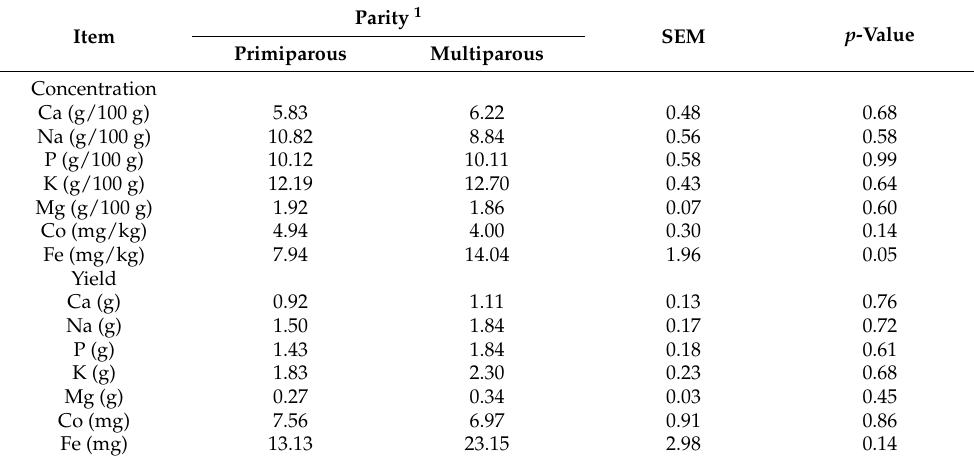
Table 4. Differences in colostrum mineral concentrations and yields between primiparous (n = 10) and multiparous (n = 10) buffaloes.